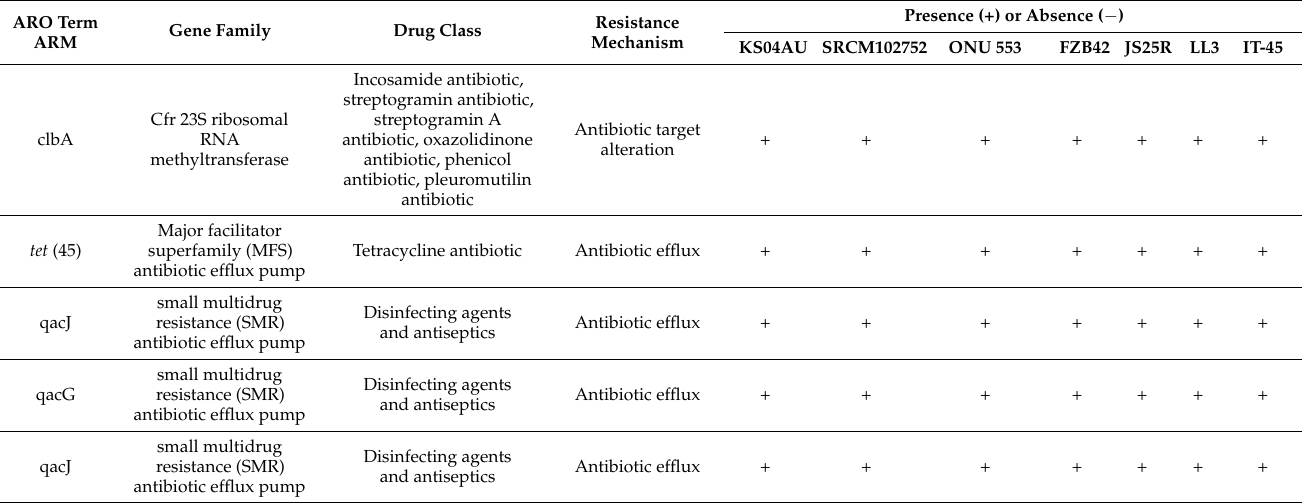
Table 8. Comparison of B. velezensis KS04AU ARM genes with closest-related